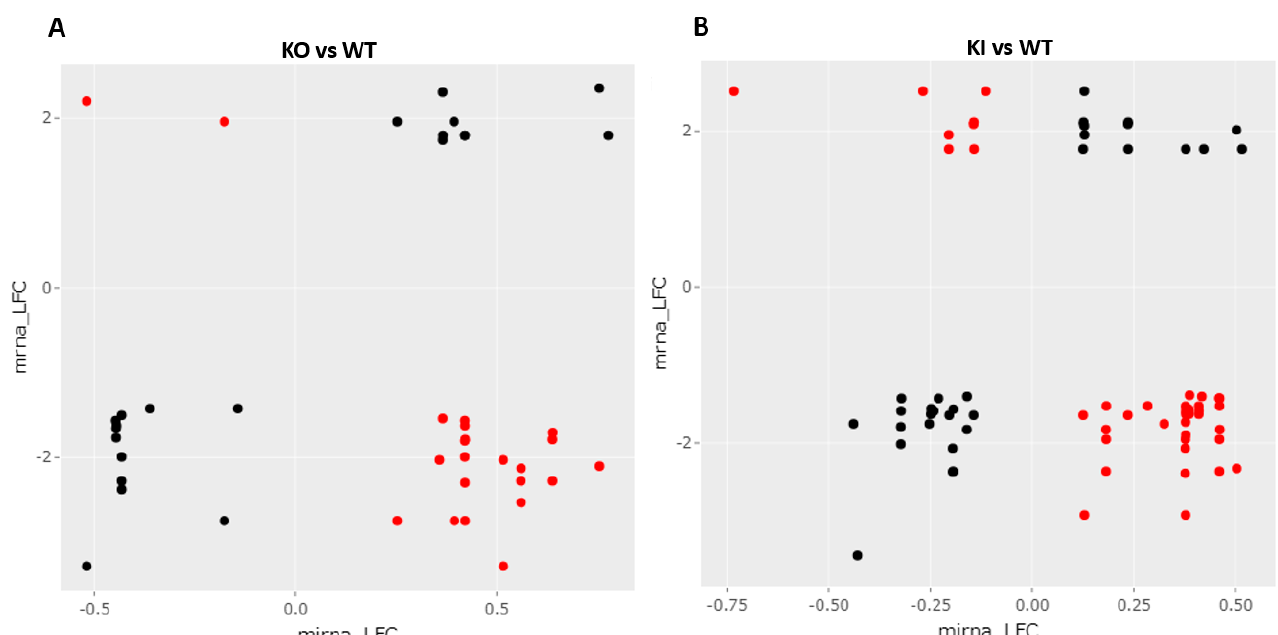
Figure 6. Correlation of mRNA–miRNA changes in the RS of KO, KI, and WT groups. mRNAs and miRNAs identified from the RS of ( A ) KO and WT group or ( B ) KI and WT group showing canonical correlation (Red, mRNA down and miRNA up or mRNA up and miRNA down) or non-canonical correlation (Black, mRNA down and miRNA down or mRNA up and miRNA up).